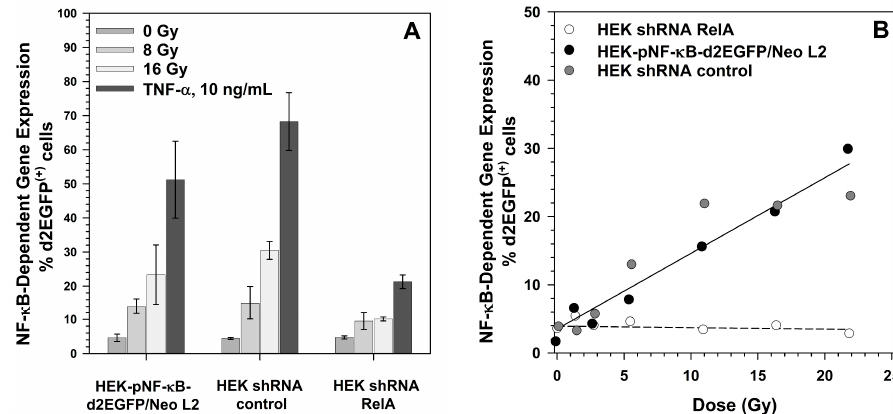
Figure 4. Effect of RelA knock-down on NF- κ B activation by X-rays and TNF- α ( A ), and by carbon ions ( B ). HEK-pNF- κ B-d2EGFP/Neo L2 cells, cells stably transfected with the shRNA control vector (HEK shRNA control) or the RelA shRNA plasmid (HEK shRNA RelA) were seeded in petri dishes, grown for two days, and exposed to X-rays (200 kV, LET ~0.3–3 keV/µm), incubated with 10 ng/mL TNF- α ( A ) or irradiated with 13 C-ions (75 MeV/n, LET 34 keV/µm). 18 h after exposure, cells were harvested by trypsination, fixed with 3.5% formaldehyde and the percentage of d2EGFP (+) cells was determined by flow cytometry.